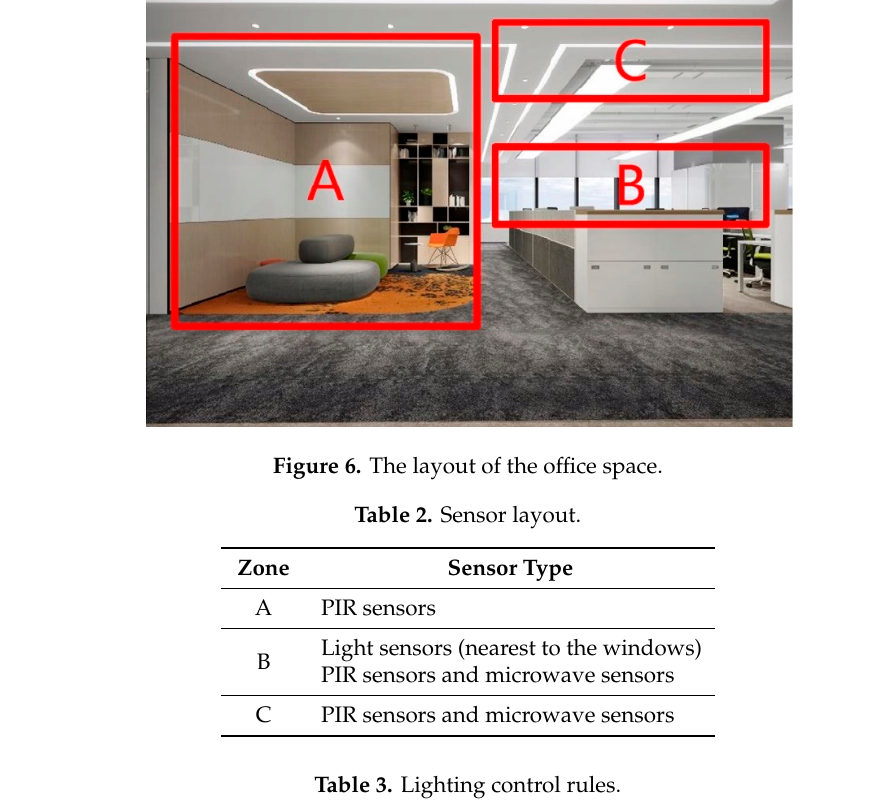
Table 3. Lighting control rules.